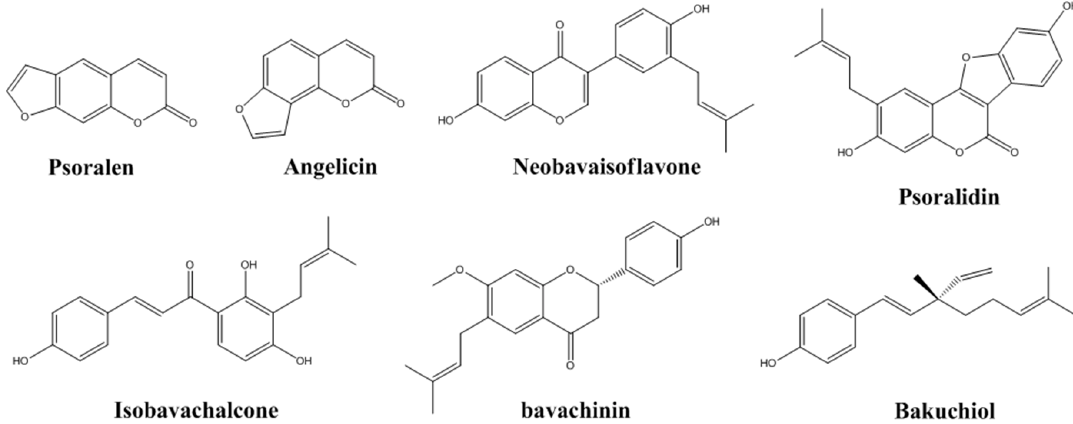
Figure 1. Chemical structures of the seven marker compounds of P. corylifolia .